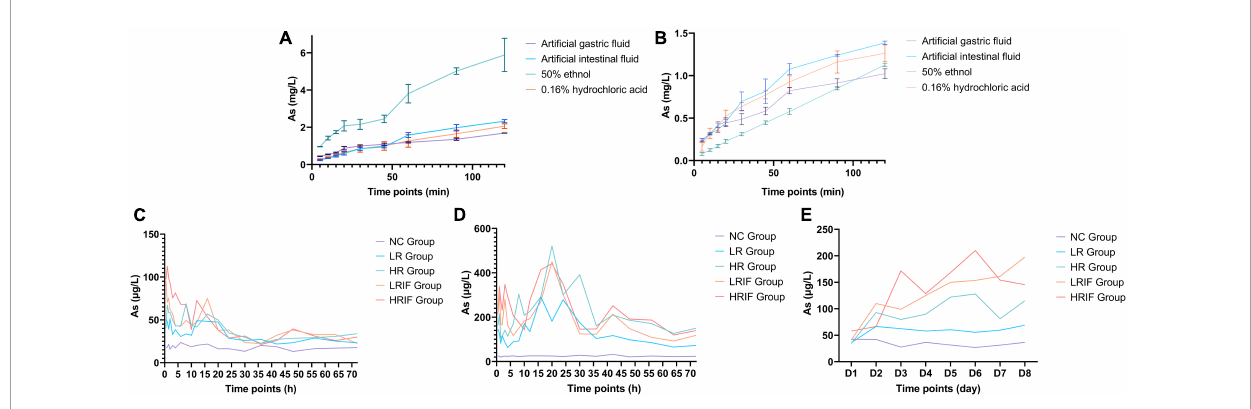
FIGURE1 In vitro and in vivo dissolution of soluble arsenic from realgar and RIF. (A) The in vitro dissolution of realgar. (B) The in vitro dissolution of RIF. (C) The in vivo dissolution of realgar and RIF after single administrations of a low dose of RIF (LRIF), high dose of RIF (HRIF), low dose of realgar (LR), high dose of realgar (HR), or empty control (NC). (D) The in vivo dissolution of realgar and RIF after continuous administrations of LRIF, HRIF, LR, HR, or NC. (E) The in vivo dissolution of realgar and RIF during continuous administration of LRIF, HRIF, LR, HR, or NC. For in vitro , N = 3; for In vivo , N =